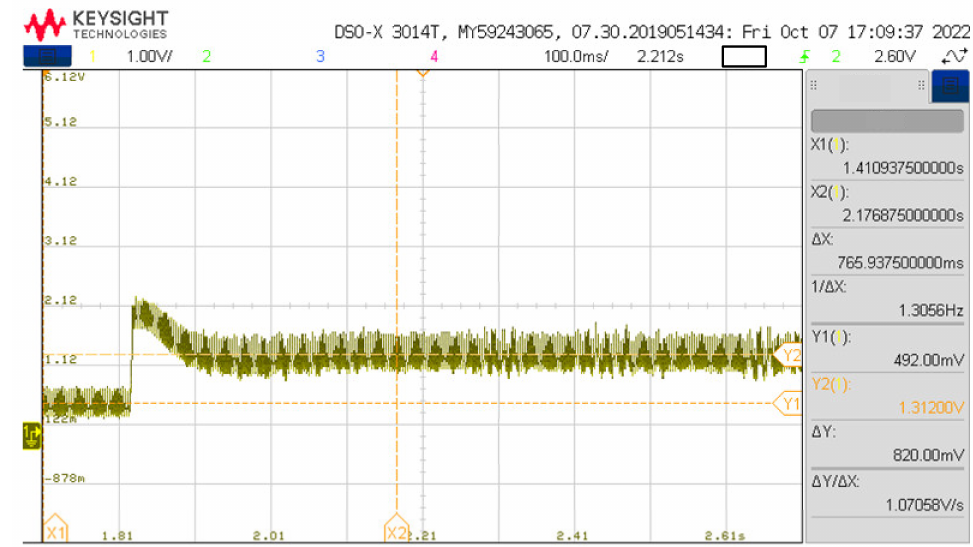
Figure 16. Voltage differential without virtual inertia